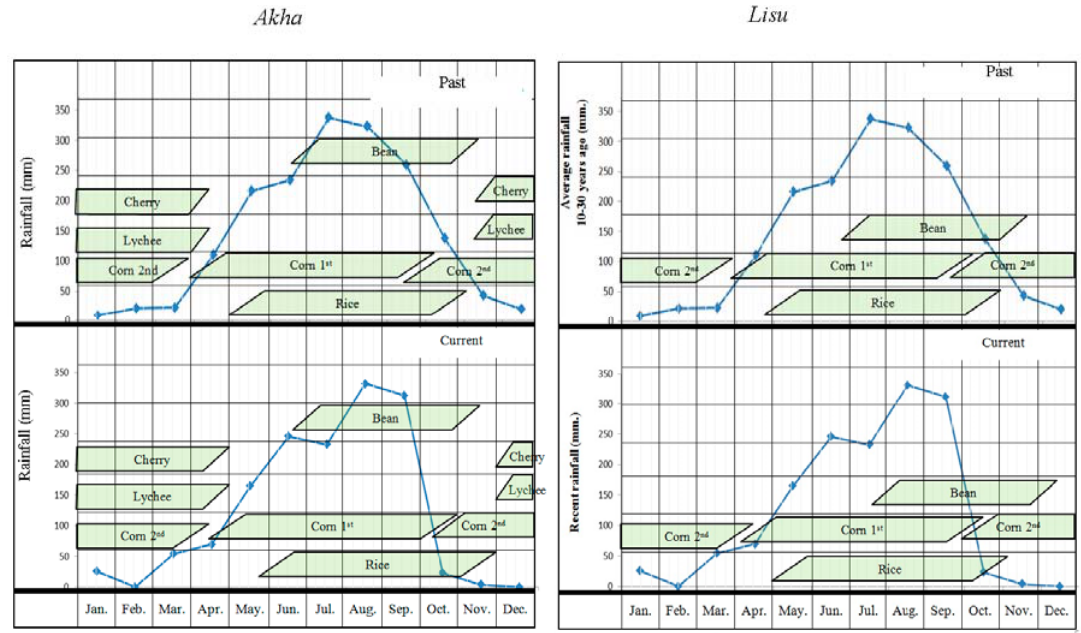
Figure 6. Current and past crop calendars of Akha and Lisu communities. Note: Current refers to the year of survey and past refers to 10–20 years ago.